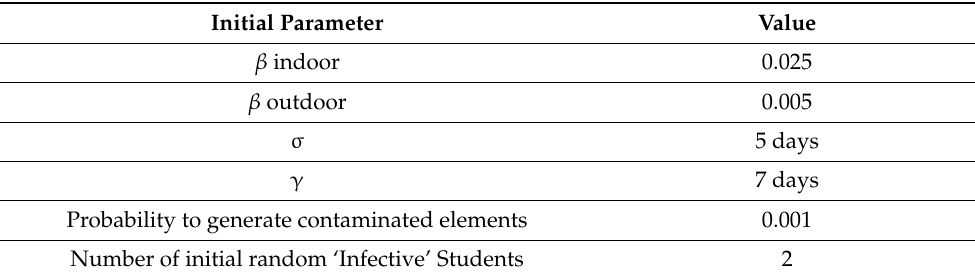
Table 7. Initial parameters used in the ABM to simulate a COVID-19